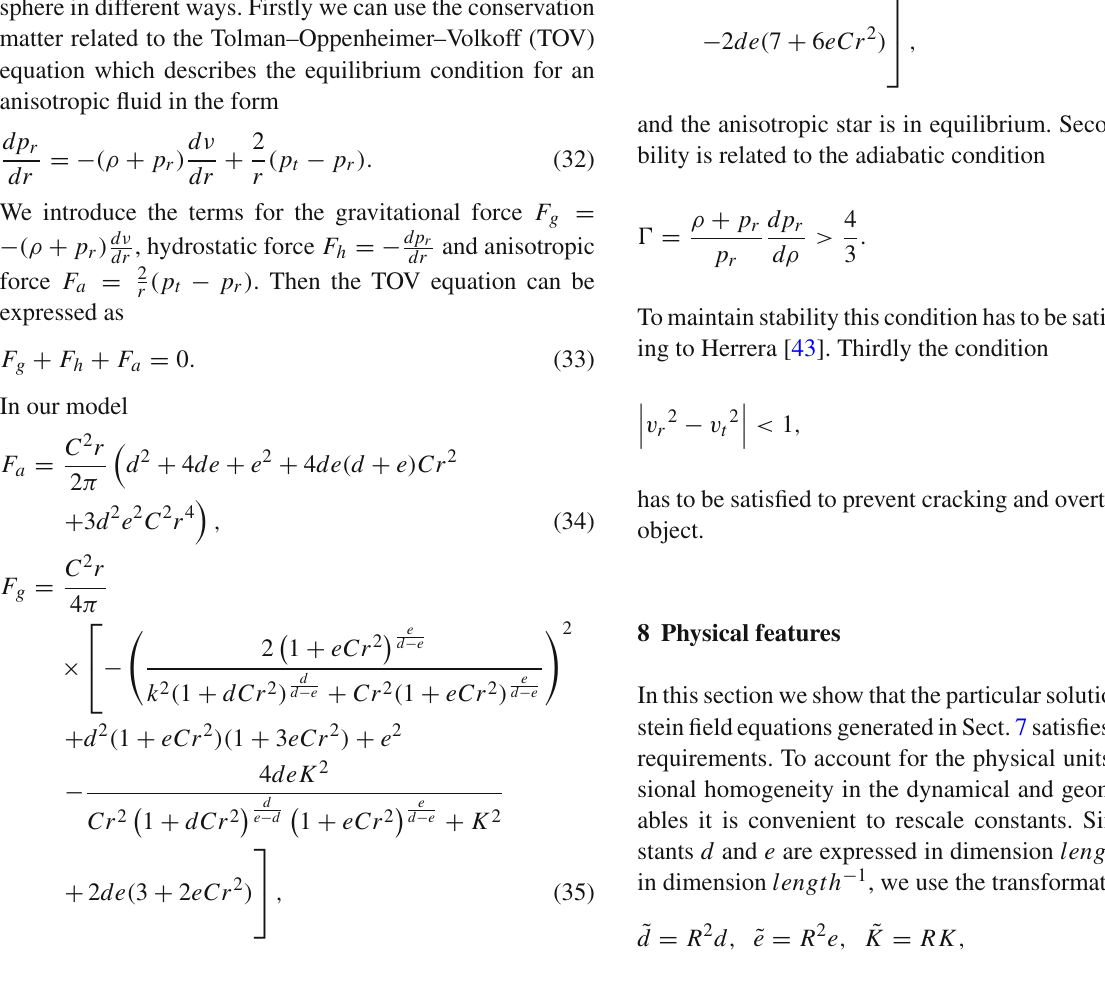
Table 4 Central density, radius, mass and compactification factor for ˜ d = − 0 . 2 and ˜ e = − 0 .